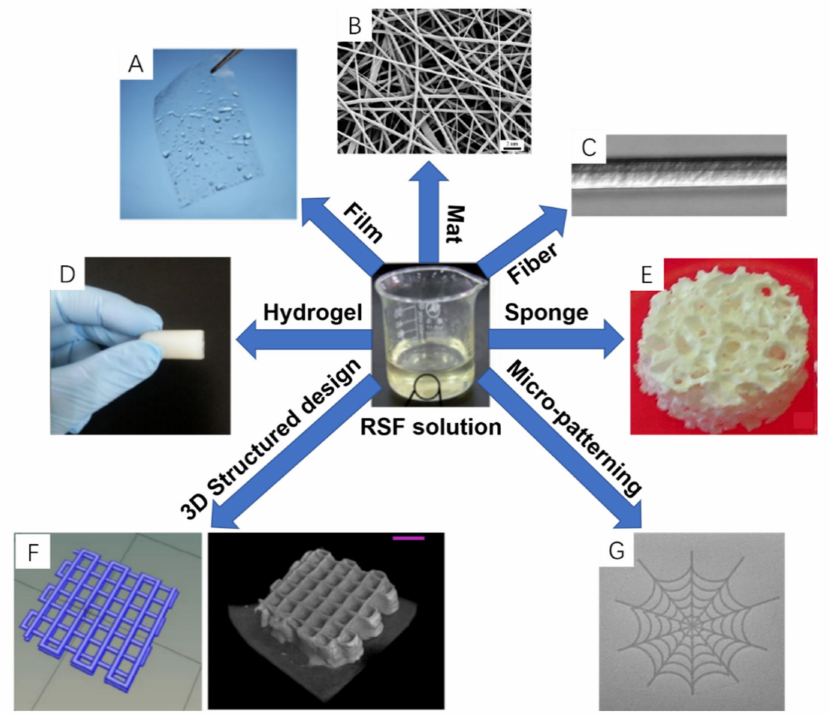
Figure 4. SF-based scaffolds with different representative structures: ( A ) Film; ( B ) Mat; ( C ) artificial fiber; ( D ) Hydrogel; ( E ) Sponge; ( F ) 3D structure design and printed scaffold; ( G ) Inkjet-printed silk pattern. Reprinted with permission from